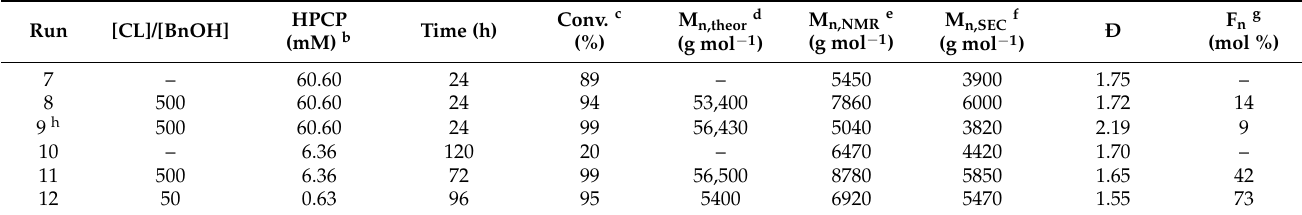
Table 2. Ring-opening polymerization of ε -caprolactone catalyzed by HPCP in bulk at 150 ◦ C a